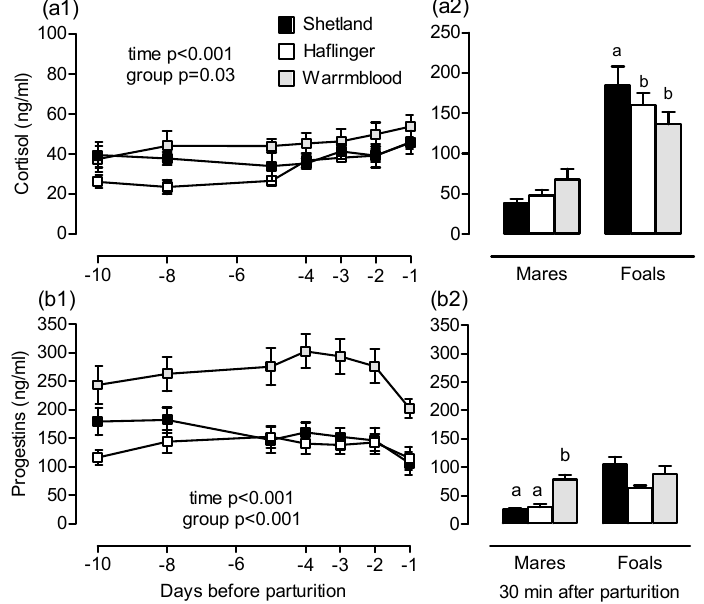
Figure 2. Concentration of ( a ) progestins and ( b ) cortisol in plasma of ( 1 ) small (Shetland), medium-size (Haflinger) and full-size (Warmblood) mares during the last 10 days before parturition and ( 2 ) in the same mares and their foals between 30 and 60 min postpartum (always before 1st suckling). Significant di ff erences are indicated in the figures (Figure a2,b2: a,b di ff erent letters indicate significant di ff erences among groups, for pairwise post-hoc comparisons see text). Note di ff erent scales on the y -axis in Figure